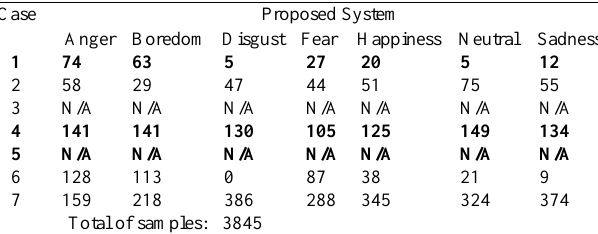
Table 4: Performance of SVM for online samples.